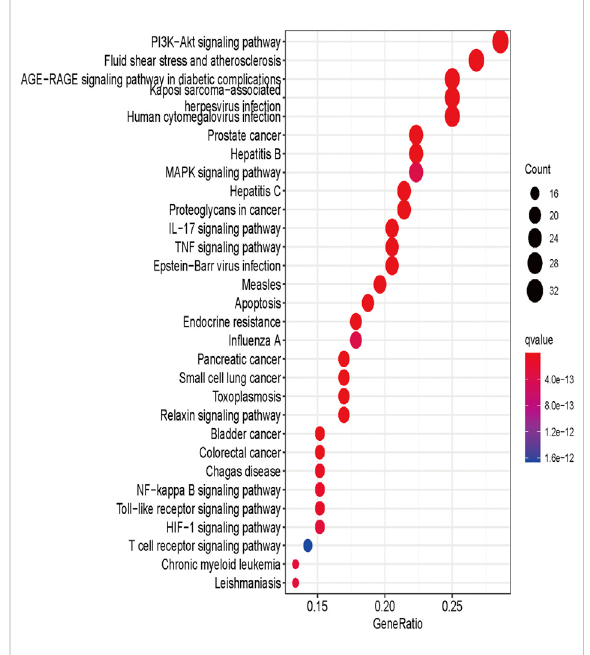
FIGURE 4 KEGG enrichment analysis of A. annua compound and AAA “ intersection target. ”